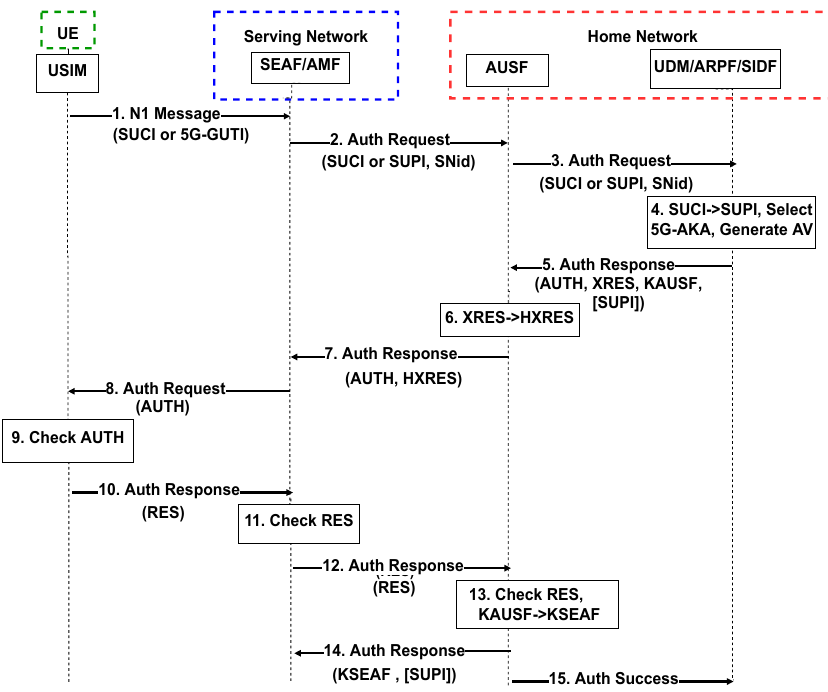
Figure 1. 5G-AKA procedure for the UE authentication